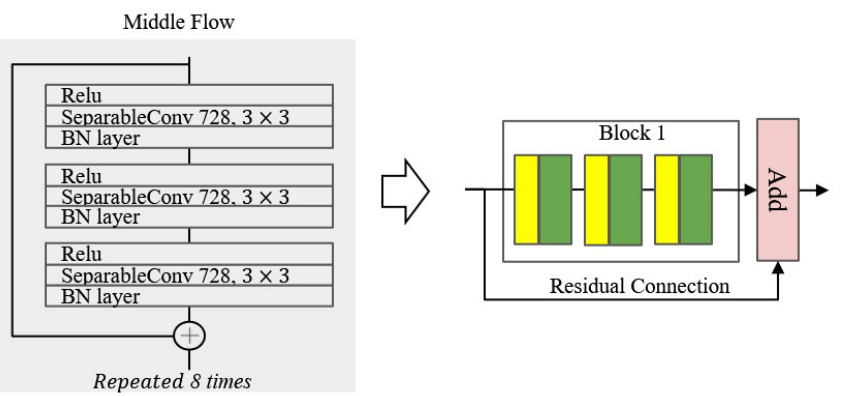
Figure 2. Extract the middle flow of the Xception structure. Note that the middle flow is a lin- ear stacked structure, repeated eight times, extracted and represented as colored parts for new modifications and reorganizations